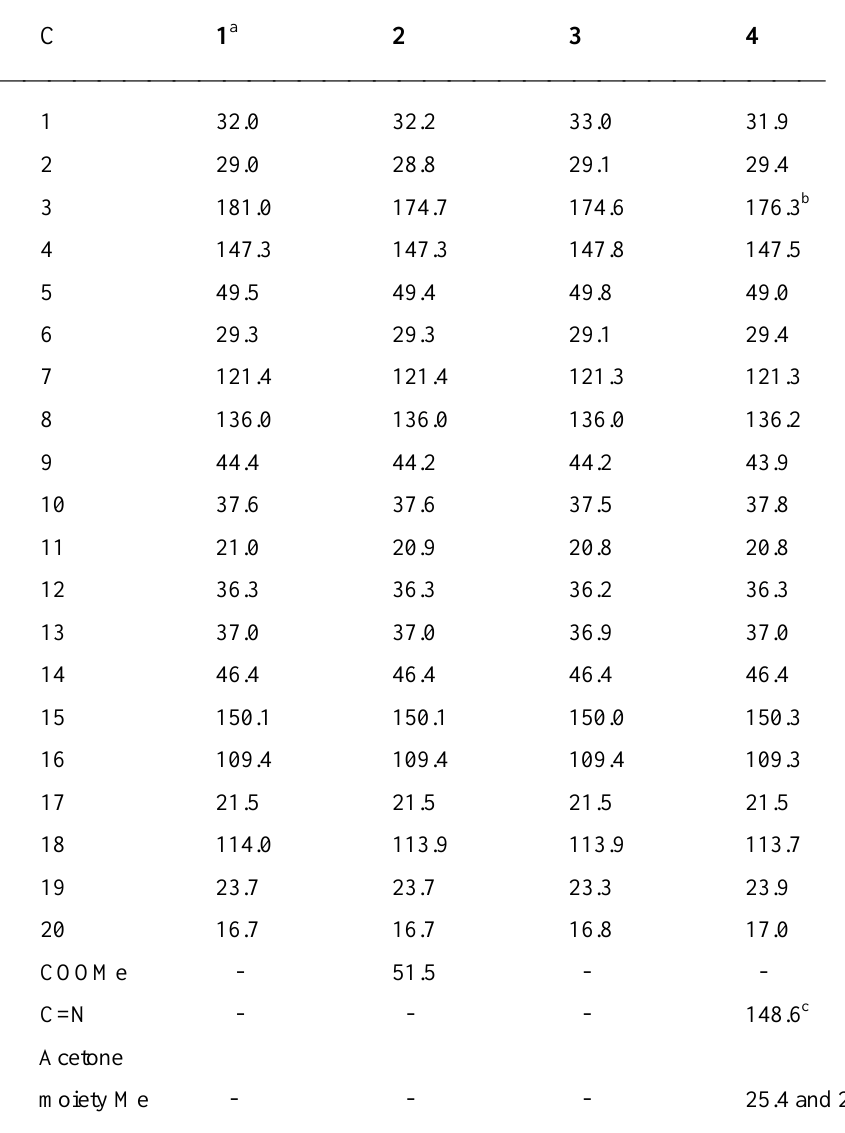
Table 1. 13 C-NMR spectral data ( δ values, CDCl